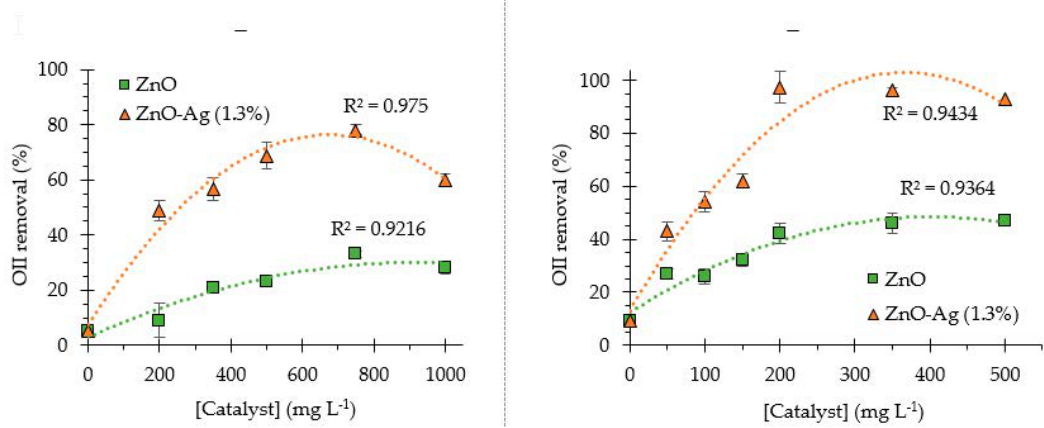
Figure 5. Influence of photocatalyst concentration under white light irradiation for 180 min ( left ) and UVA light irradiation for 60 min ( right ). Error bars were calculated considering a normal distribution, for p < 0.01 [obtained from kinetic data]. Table 1. Kinetic parameters for the photodegradation of OII with ZnO–Ag (1.3%) and ZnO NPs.